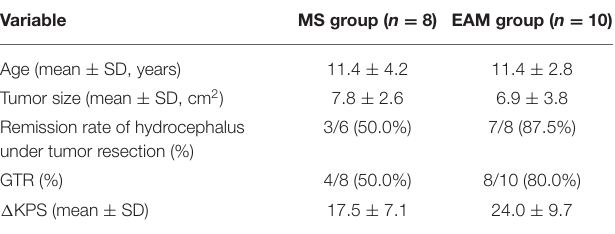
TABLE 2 | Comparison of clinical outcomes in MS group and EAM group.